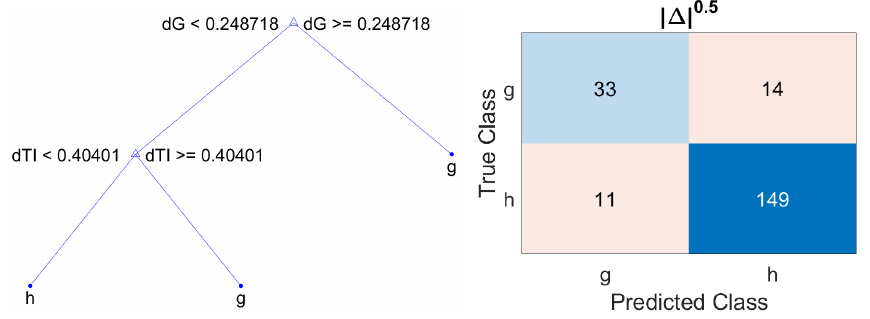
Figure 7. Notched box plots of the proposed RNFL thickness asymmetry metric | ∆ S | 0.5 for the healthy (h) and glaucoma (g) subsets of patients, depicted for each eye sector (TS, T, TI, NS, N and NI) and for the overall global thickness value (G).